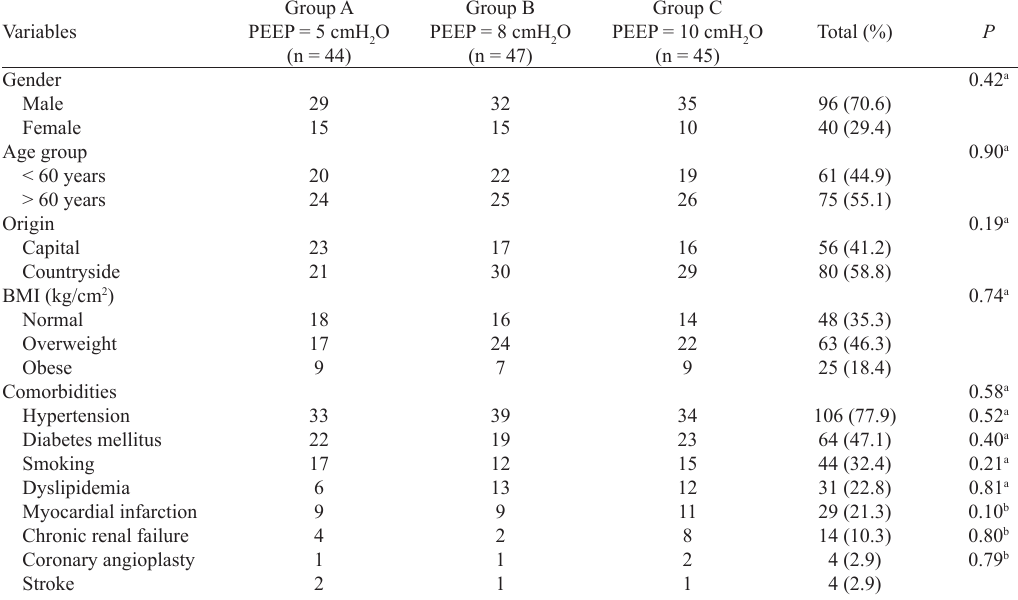
Table 1. Demographic and clinical data for patients undergoing